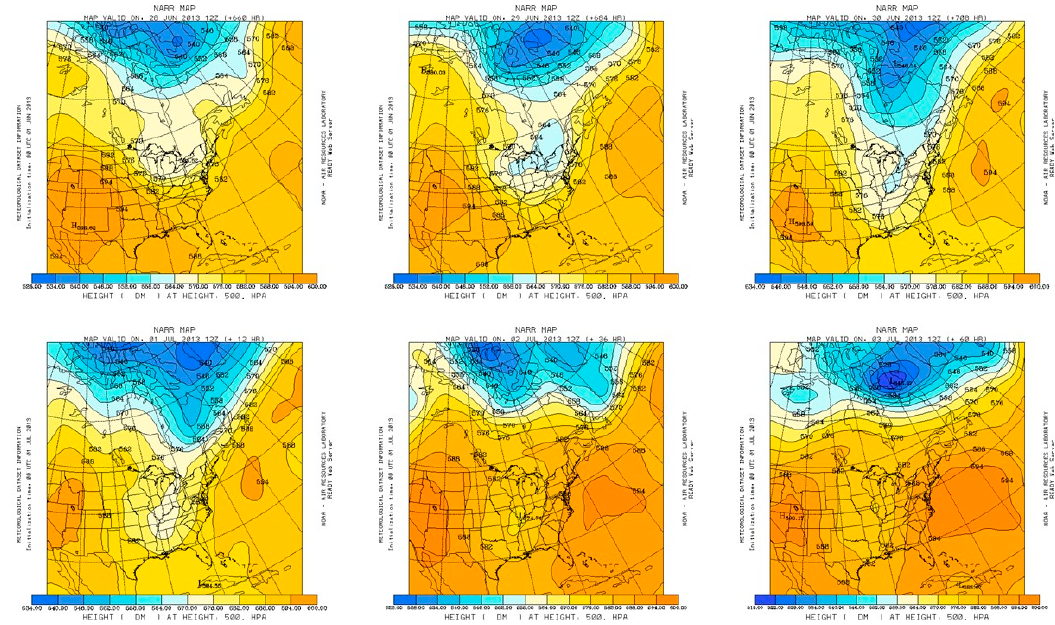
Figure 14. Daily 500 hPa GPH from 28 June (upper left) to 3 July (lower right), 2013. Credit: NOAA ARL.